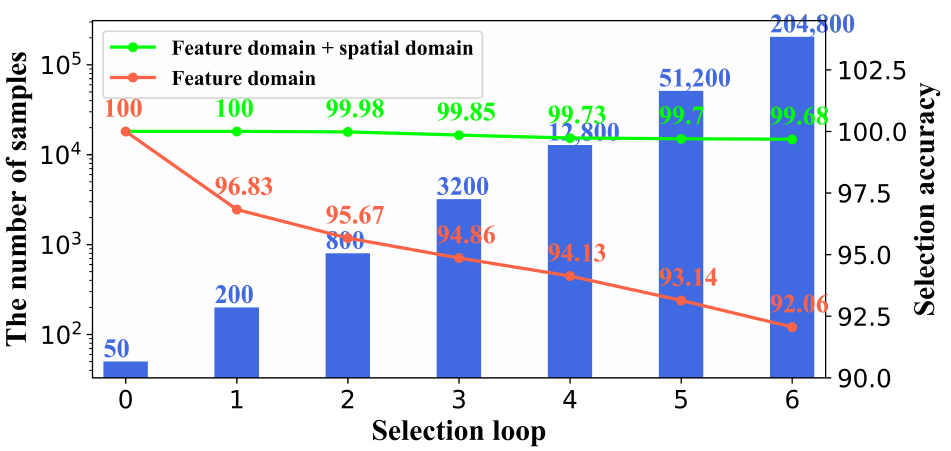
Figure 20. The number of training samples and the accuracy of the selected